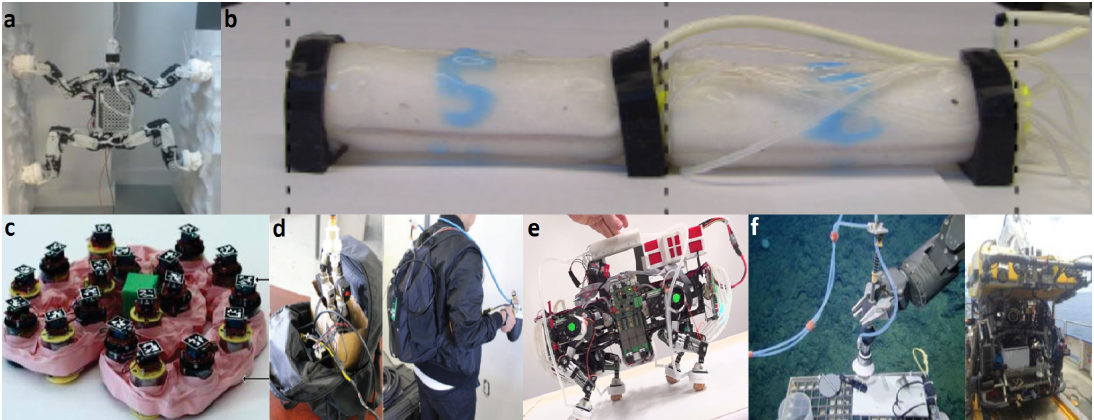
Figure 2. A diverse array of jamming actuated soft robots designed for unique environments and applications. From left to right, top to bottom: ( a ) a locomotive, humanoid, rigid robot using granular jamming paws to vertically ascend a rigid shaft via exploiting the jamming transition to increase compliance and friction against irregularly shaped walls [60], ( b ) a wormbot that crawls via bending moments created by combinations of McKibben actuation and jamming cells [5], ( c ) an ant-bioinspired granular jamming swarm gripper comprising of independently controllable sub-robots capable of surrounding a target object, jamming to grasp it and transporting it via wheeled leg locomotion [35], ( d ) a prostheses device incorporating a granular jamming bag gripper which was designed to assist amputees with daily living tasks including object grasping and manipulation [18], ( e ) a rigid four-legged locomotive robot utilizing granular paws with rubber cube packings with goals to increase damping and terrain compliance, and reduce slippage, during locomotion on smooth and rough surfaces [59], and ( f ) a remotely operated underwater vehicle capable of grasping and manipulating delicate deep-sea objects through a hydraulically actuated granular jamming gripper which engenders stronger grasps as environmental pressure increases